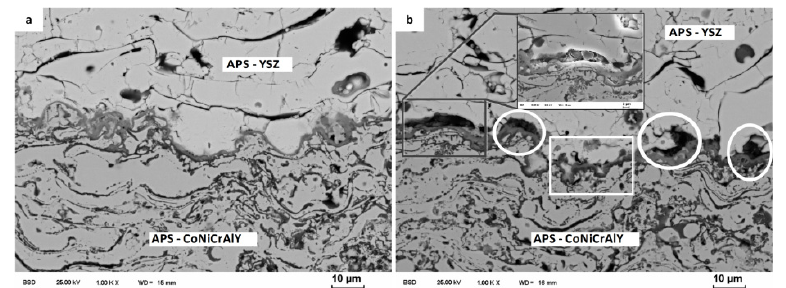
Figure 3. Backscattered scanning electron microscopy images (BSD-SEM) presenting the coatings